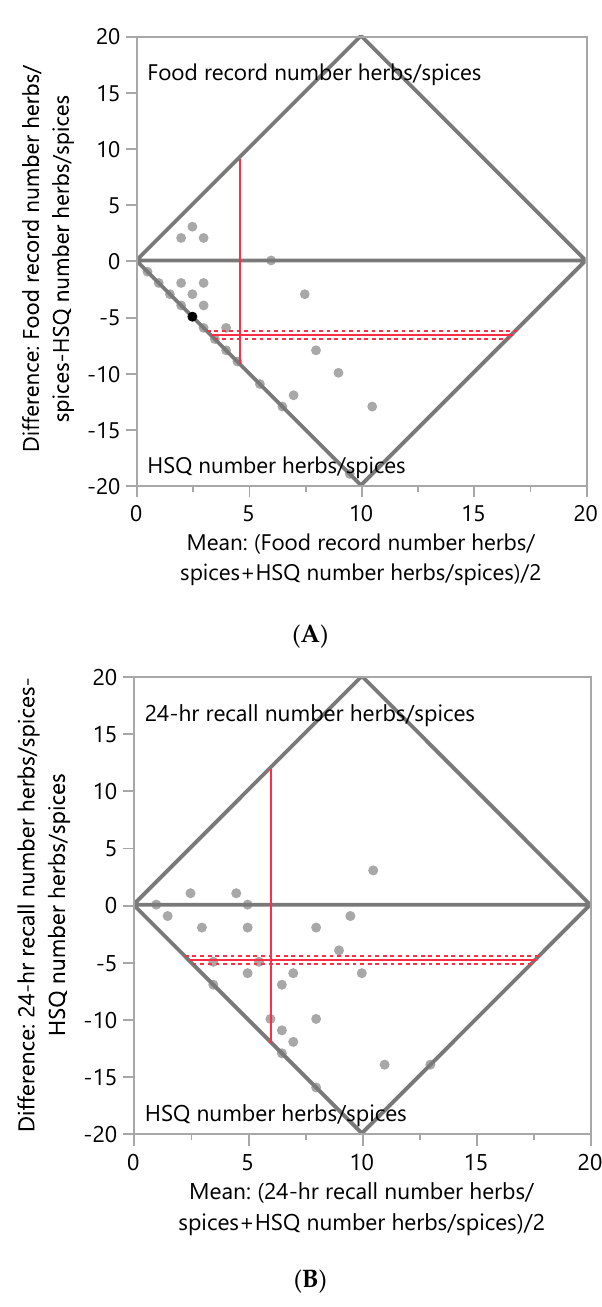
Figure 1. Bland–Altman Plots of the number of herbs and spices consumed per month. ( A ) Difference in number of herbs and spices consumed between the Herb/Spice Questionnaire (HSQ) and food records. N = 33 respondents; mean difference between methods = − 6.5, Wilcoxon signed rank test, p < 0.0001. ( B ) Difference in number of herbs and spices consumed between the HSQ and 24-h recalls. N = 29 respondents; mean difference between methods = − 4.7, Wilcoxon signed rank test, p < 0.0001. The mean difference is shown as the horizontal solid red line, with the 95% confidence interval above and below shown as red dotted lines. The mean of pairs is shown by the vertical red line.